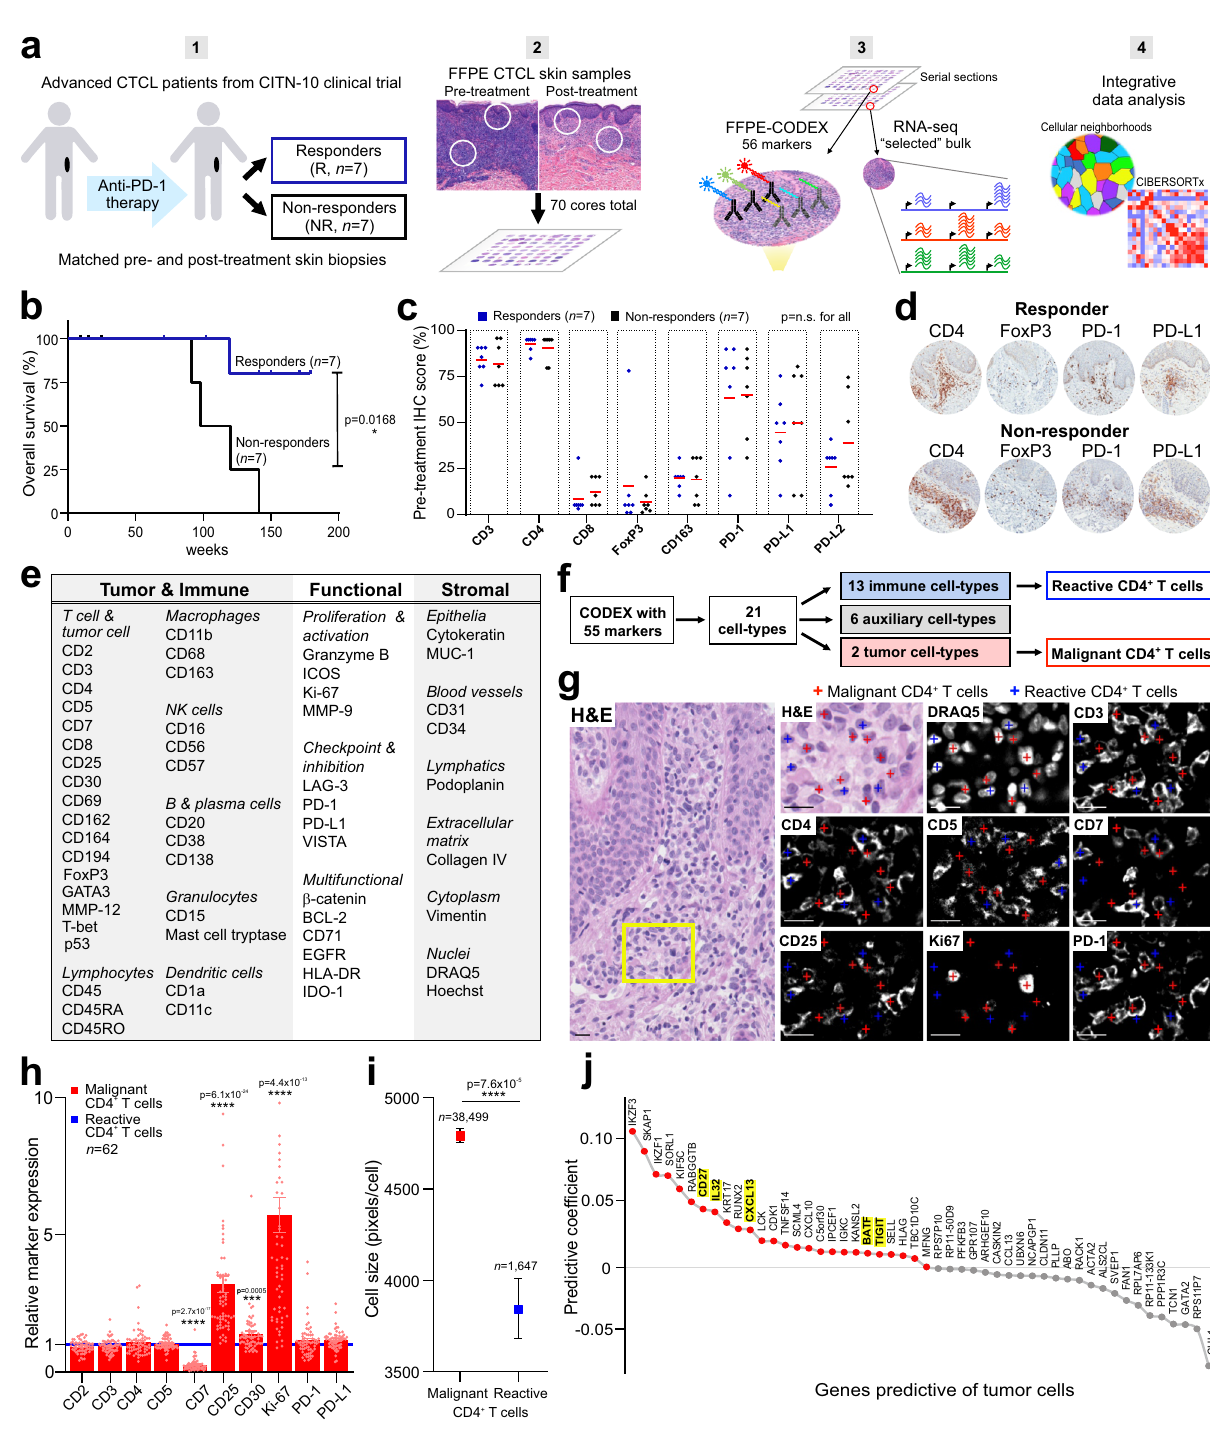
genes predictive of the frequency of tumor cells per tissue microarray spot by fi tting an L1-regularized linear model to bulk RNA-seq data. This con fi rmed that higher expression of several known CTCL marker genes, including CD27 , IL-32 , CXCL13 , BATF , and TIGIT 28 – 32 , was associated with spots with higher frequencies of tumor cells (Fig. 1j, see yellow highlighted genes). Notably, CTCL tumor cells can also express FoxP3 33 , as seen for one patient in this cohort. Our clustering approach identi fi ed this population of malignant FoxP3 + CD4 + T cells, which differed signi fi cantly from Tregs, with lower CD4, CD7, CD25, and FoxP3 marker expression and larger cell size (Supplementary Fig.